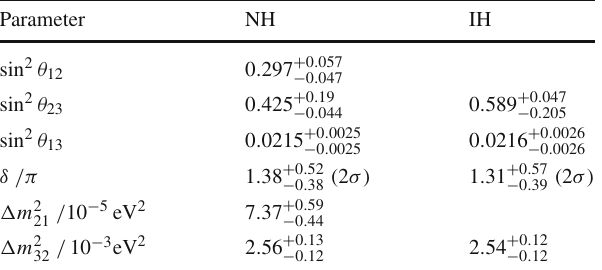
Table 2 Best-fit neutrino oscillation parameters with associated 3 σ experimental uncertainty. Results are given both assuming normal ordering and inverted ordering. Table is taken from [39]